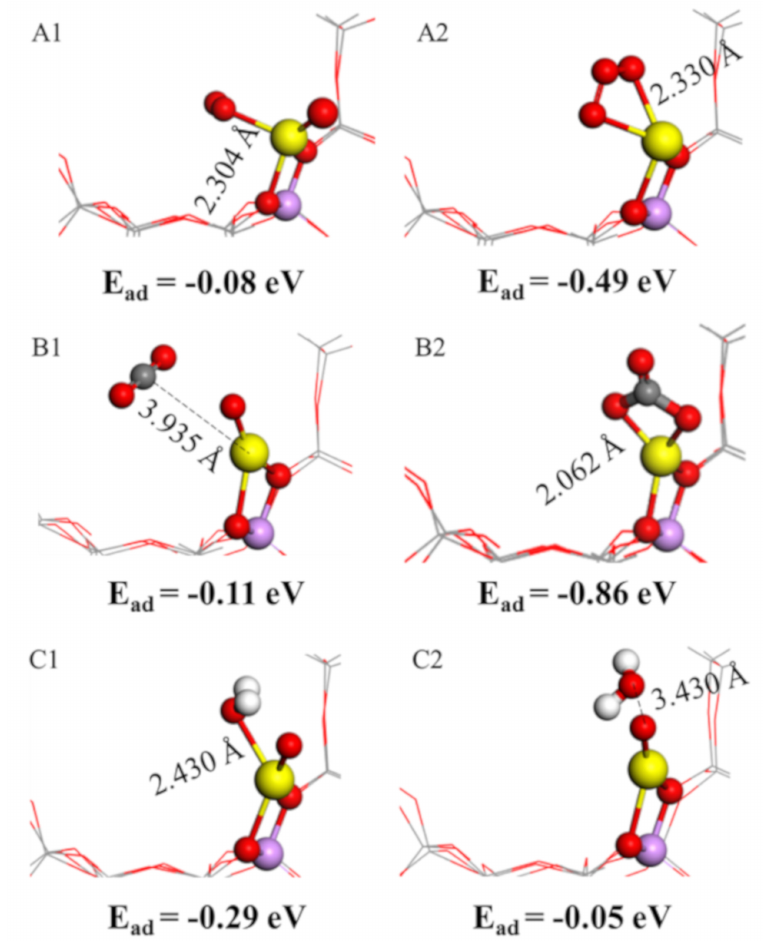
Figure 7. Optimized structures of O 2 , CO 2 , and H 2 O molecules adsorbed on L-model of In / BEA: O 2 molecule on In site ( A1 ); O 2 molecule on O site ( A2 ); CO 2 molecule on In site ( B1 ); CO 2 molecule on O site ( B2 ); H 2 O on In site ( C1 ); H 2 O on In site ( C2 ). Table 5. Bond length ( d , Å), Mulliken charge population ( q , e) and adsorption energy (Eads, eV) of O 2 , H 2 O, and CO 2 adsorption on L-model. O 2 CO 2 H 2 O In site O site In site O